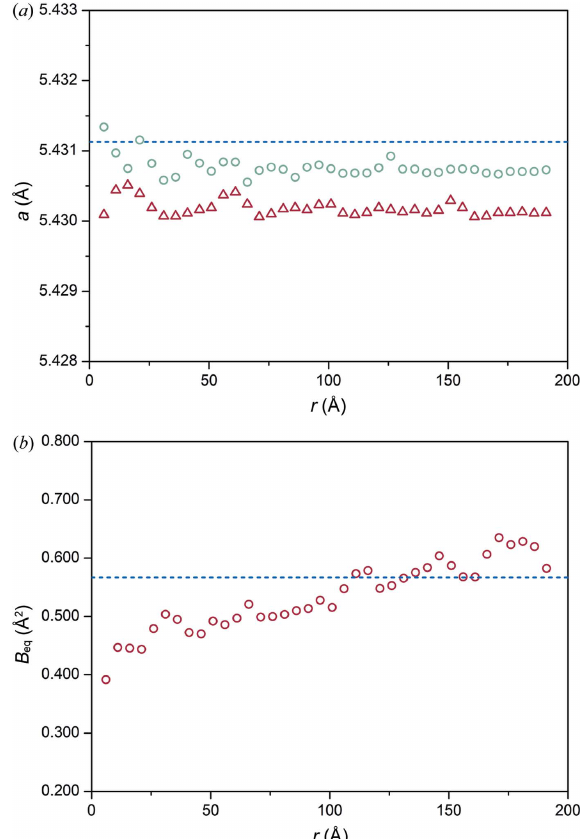
Figure 1 Data obtained from NIST Si 640d show ( a ) the PDF- and Bragg peak- derived lattice parameters are comparable and the PDF-derived value does not significantly change across r , where the circles are the lattice parameters corrected for peak shape and zero offset, and the triangles are the lattice parameter without correcting for peak shape and zero offset; and ( b ) the ADP increases across r due to peak broadening. The blue dashed lines indicate the lattice parameter and ADP obtained from Rietveld